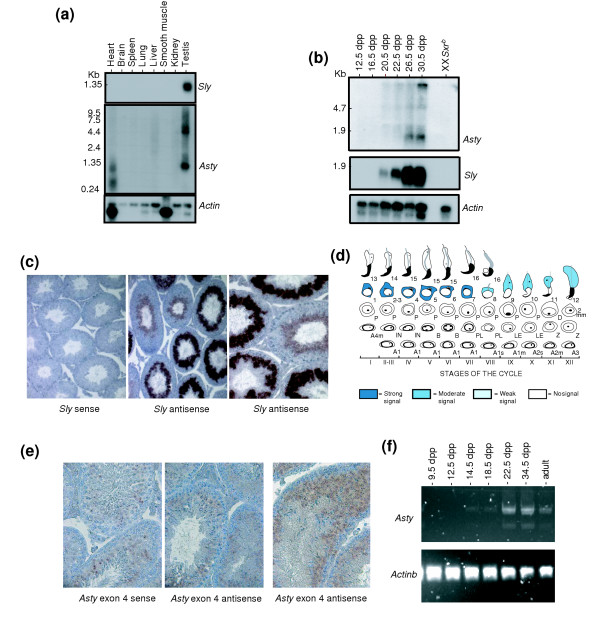
Sly and Asty/Asty(rec) are expressed in spermatids. (a) A multi-tissue northern blot of polyA+ RNA probed with Sly clone MTnH-K10 and Asty exon 4 probe. Sly transcripts are restricted to the testis, but Asty/Asty(rec) transcripts are also seen in the heart. (b) A northern blot of total testis RNA from testes of mice aged 12.5-30.5 days postpartum (dpp) hybridized with the same Sly and Asty probes. No transcripts are detectable before 20.5 dpp, suggesting that the transcripts are restricted to spermatid stages. (c) RNA in situ analysis confirming that Sly transcription in the testis is predominantly if not exclusively in spermatids. (d) Diagram summarizing the expression of Sly in spermatids throughout the spermatogenic cycle. The spermatogenic stages starting from the basal layer and reading left to right are: spermatogonia: A1 through to B; meiotic prophase spermatocytes: preleptotene (PL), leptotene (LE), zygotene (Z), pachytene (P), diplotene (D); meiotic divisions (mm); postmeiotic spermatid stages: 1-13. (e) RNA in situ analysis with the Asty exon 4 probe that should detect Asty and Asty(rec) transcripts. The most convincing signal is in round spermatid nuclei, but this is seen with the antisense and sense (control) probes. However, the previously reported cDNA clone BU936708 (Additional data file 3) contains Asty exon 4 sequence in the antisense oritentation and which would hybridize with the sense probe. (f) Exon 1-4 Asty reverse transcriptase polymerase chain reaction from 9.5 dpp to adult testes. Sequencing of the cloned amplification products confirmed the presence of full-length Asty transcripts at 14.5 dpp, and a shorter transcript lacking exon 3 from 22.5 dpp.